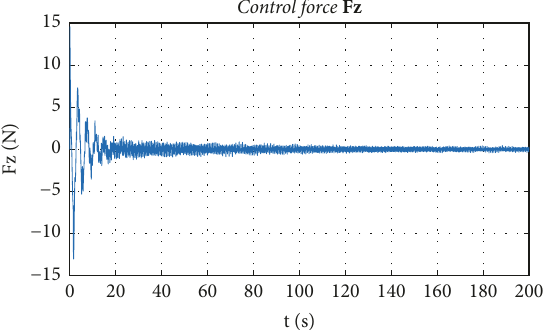
Figure 13: Control force 𝐹 𝑍 with vibration